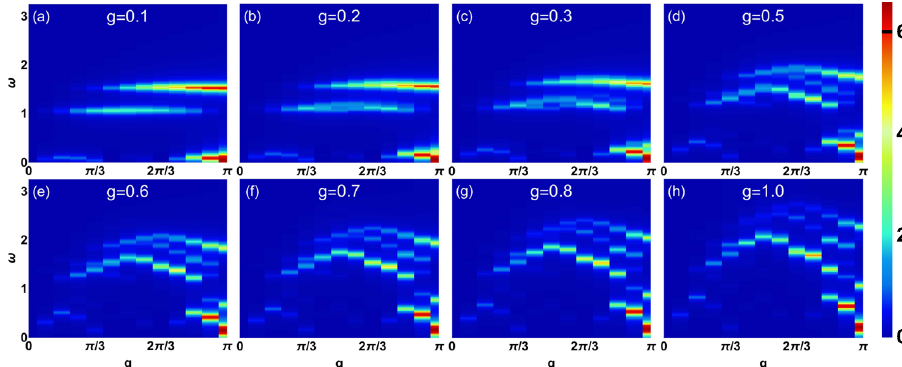
Fig. 8 Dynamic spin structure factor ~ S zz ð q ; ω Þ obtained by ED in the truncated Hilbert space. a – h are the ED calculations for different g values. Here, the system with L = 24 spins ( N = 8 unit cells) is considered. A Lorentzian broadening of width 0.05 was used of the δ functions in Eq. 26. The boundary between the linear and logarithmic color mapping is U 0 = 6 (see de fi nition in the caption of Fig. 2) as indicated on the color bar.